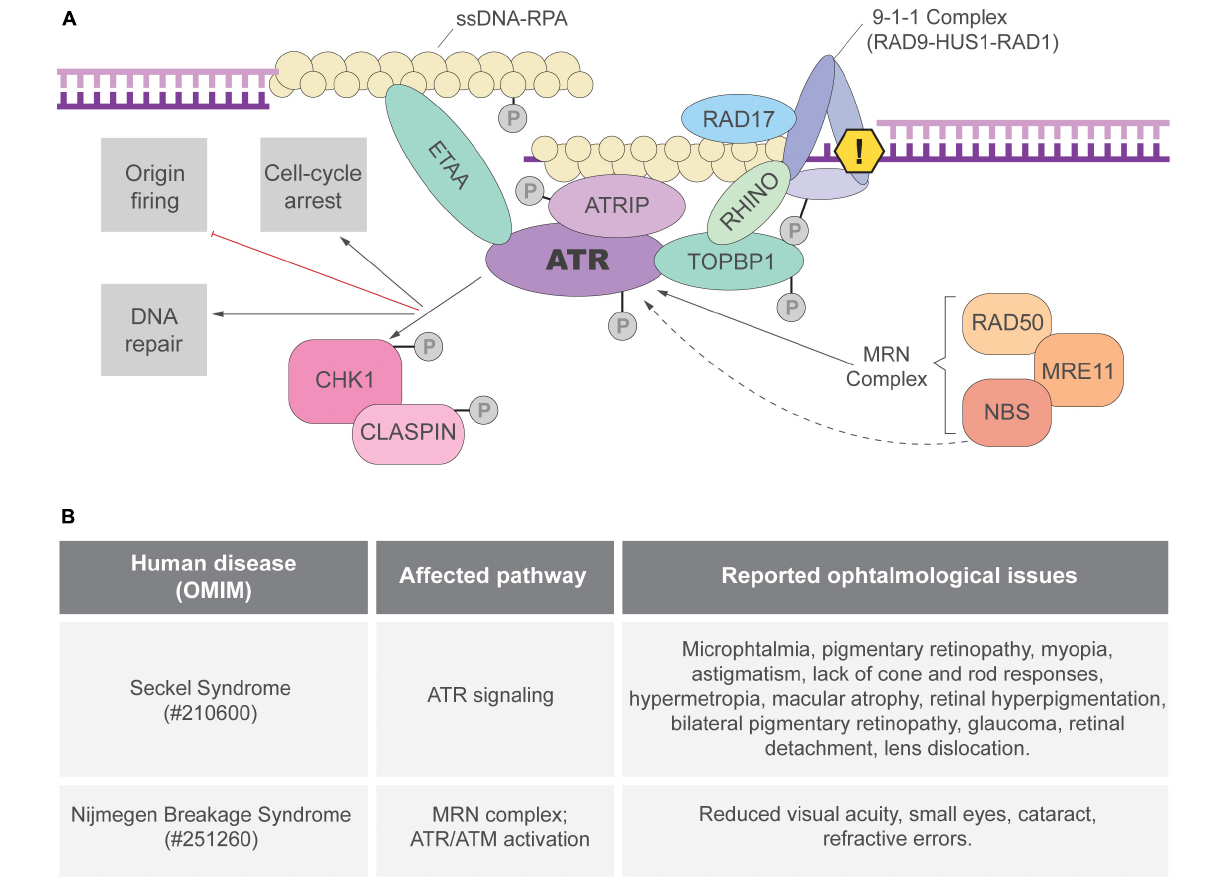
FIGURE 1 | ATR activation and the replication stress response (RSR). (A) The ATRIP-ATR complex is recruited to RPA coated ssDNA. ATR can be directly activated by TOPBP1 or ETAA1 via their AAD domain. In regions of dsDNA-ssDNA junctions, the 9-1-1 complex is responsible for TOPBP1 recruitment and ATR activation. ETAA1-mediated ATR activation is not dependent on ssDNA-dsDNA junctions as ETAA1 directly binds to RPA-coated ssDNA. RHINO and the MRN complex are also important for ATR activation that phosphorylates different targets, including the CHK1 kinase. Once the RSR is activated, ATR and its downstream targets can modify different aspects of cell metabolism to prevent genome instability. (B) Ocular manifestations reported in patients of the RSR-related syndromes: Seckel (Lim and Wong, 1973; Guirgis et al., 2001; Reddy and Starr, 2007; Aktas et al., 2013; Krzyzanowska-Berkowska et al., 2014) and Nijmegen breakage syndromes (Varon et al., 1998; Gralek et al.,